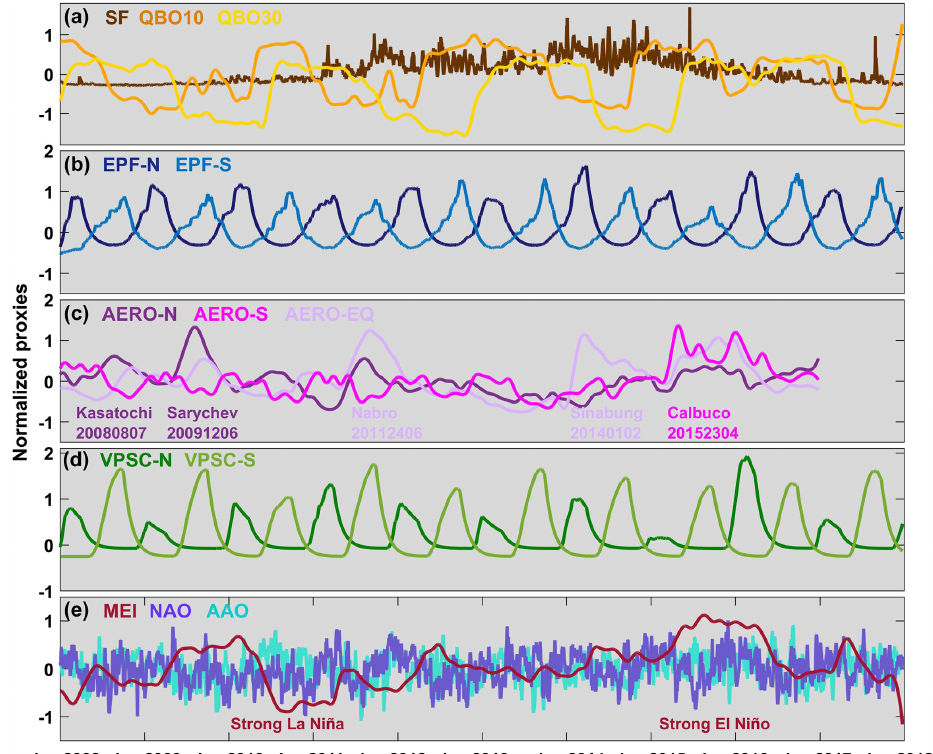
Figure 2. Normalized proxies as a function of time for the period covering January 2008 to December 2017 for (a) the F10.7cm solar radio flux (SF) and the equatorial winds at 10 (QBO10) and 30hPa (QBO30), respectively; (b) the upward components of the EP flux crossing 100hPa accumulated over time and averaged over the 45–75 ◦ latitude band for each hemispheres (EPF-N and EPF-S); (c) the extinction coefficients at 12µm vertically integrated over the stratospheric O 3 column (from 150–2hPa) and averaged over the extratropics north and south (22.5–90 ◦ N–S; AERO-N and AERO-S) and over the tropics (22.5 ◦ S–22.5 ◦ N; AERO-EQ) (the main volcanic eruptions are indicated); (d) the volume of polar stratospheric clouds multiplied by the equivalent effective stratospheric chlorine (EESC) and accumulated over time for the Northern and Southern Hemispheres (VPSC-N and VPSC-S); and (e) the El Niño–Southern Oscillation (ENSO), North Atlantic (NAO) and Antarctic (AAO)